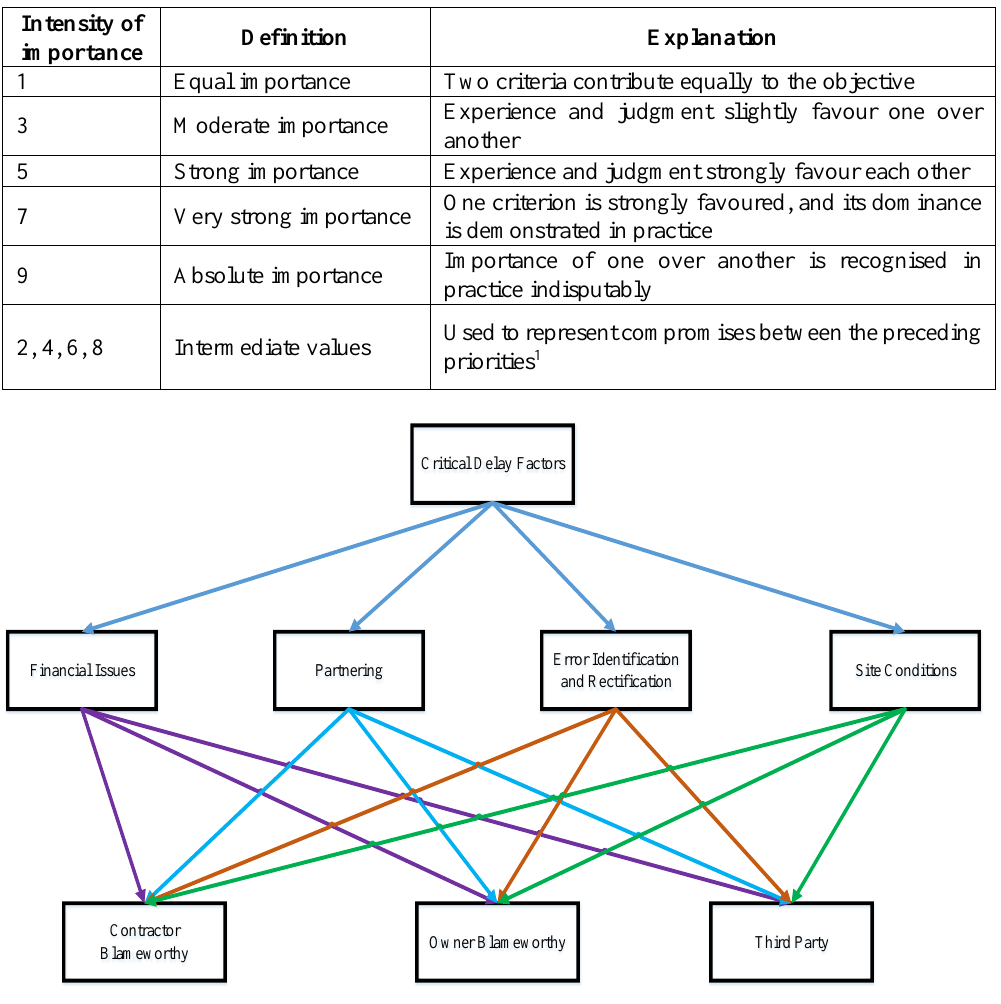
Fig. 1. Decision hierarchy (developed by the